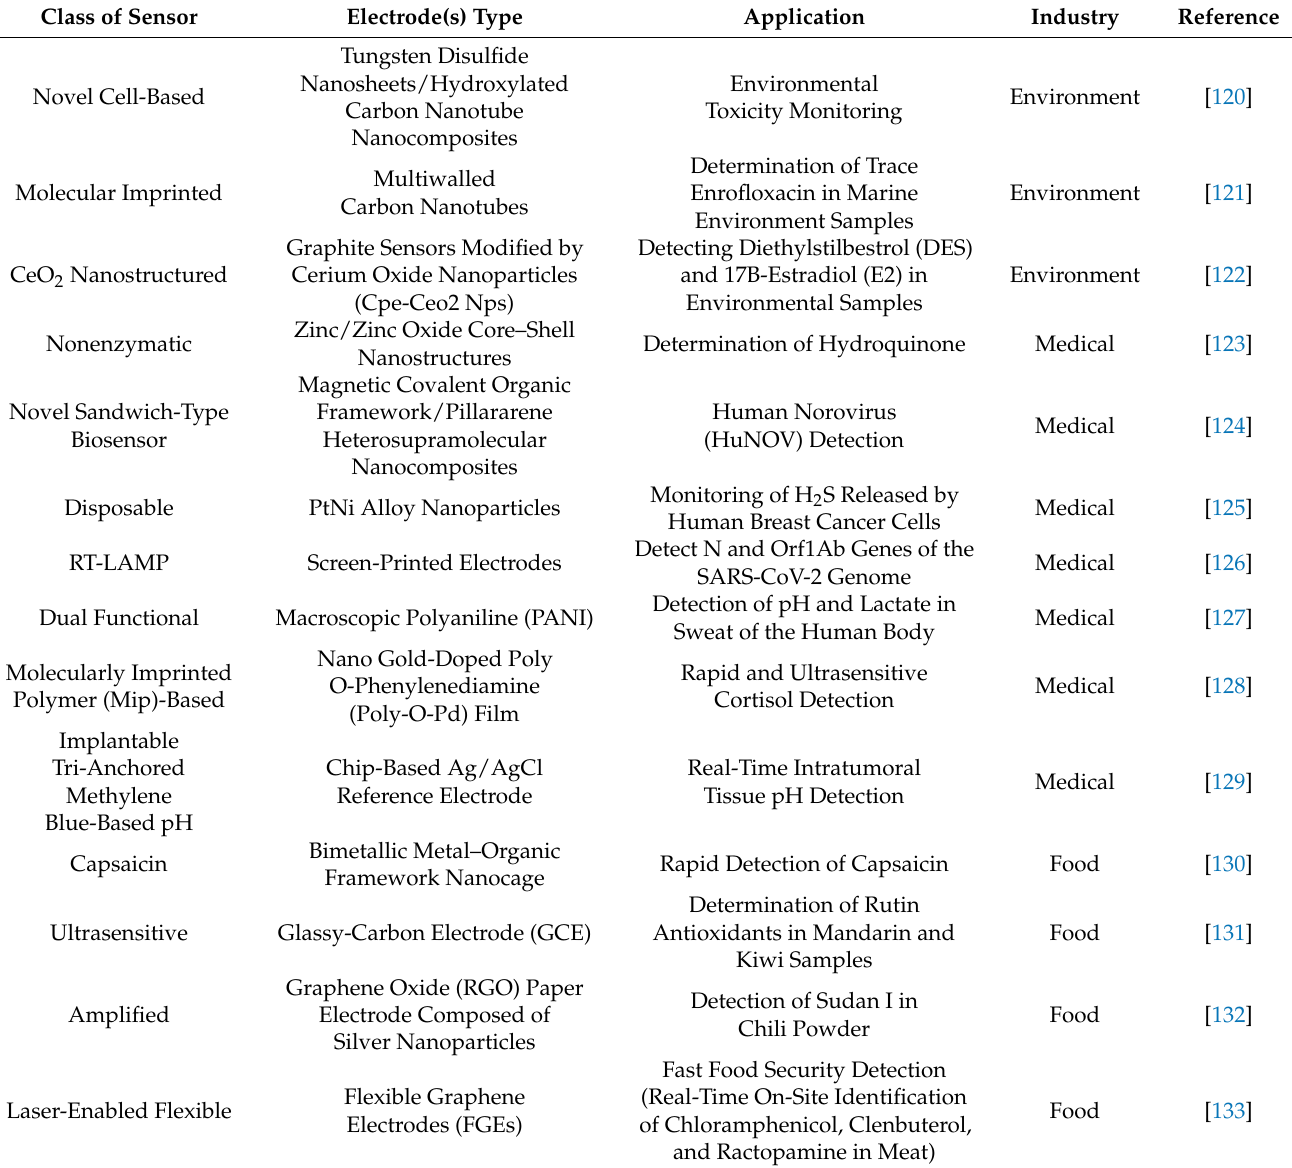
Table 5. Electrochemical sensor types and its relevance in diverse